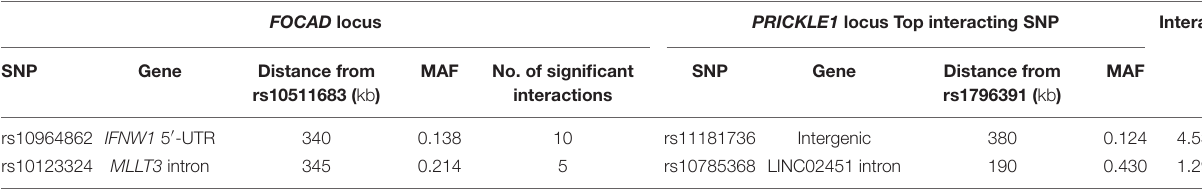
TABLE 2 | Locus-level replication analysis of FOCAD × PRICKLE1 detected significantly interacting SNP pairs between one of the two SNPs (rs10964862 and rs10123324) at the FOCAD locus and different PRICKLE1 SNPs. FOCAD locus PRICKLE1 locus Top interacting SNP Interaction p